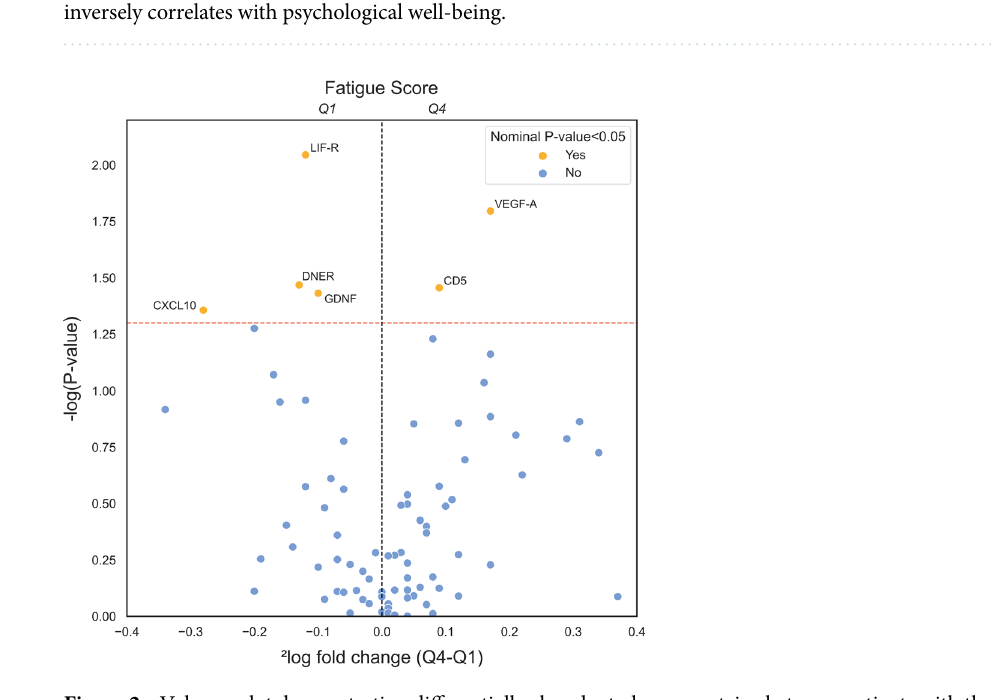
Figure 2. Volcano plot demonstrating differentially abundant plasma proteins between patients with the lowest (Q1, range 0–3) and highest (Q4, range 6–10) fatigue scores. The red horizontal dashed line indicates the threshold for nominal significance (nominal P < 0.05), and the vertical black dashed line indicates zero difference between the groups. Abbreviations: Q1, first quartile; Q4, fourth